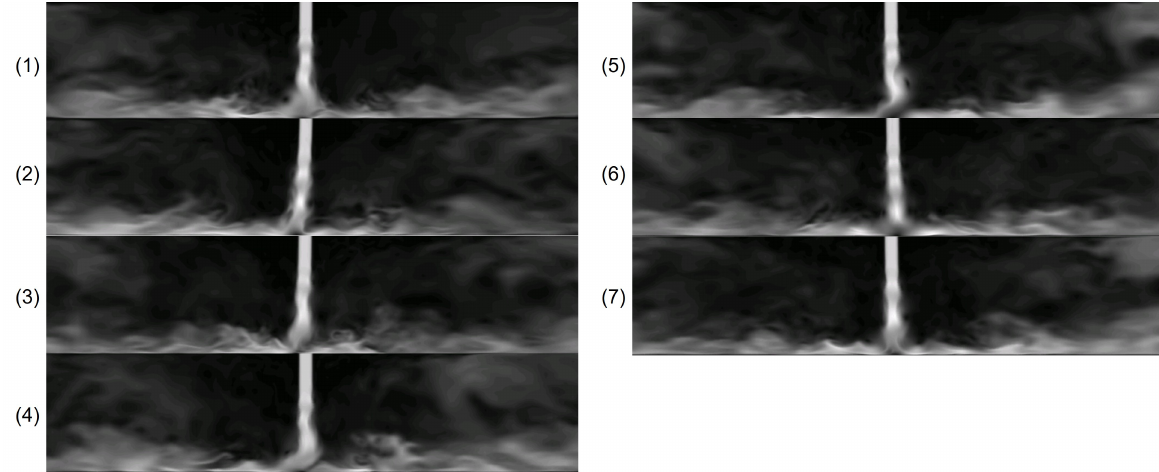
Figure 13. Flow visualization of a complete period of